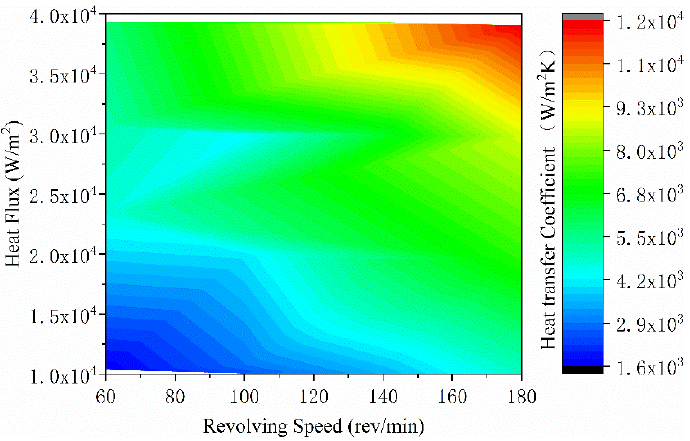
Figure 9. The boiling heat transfer coefficient.